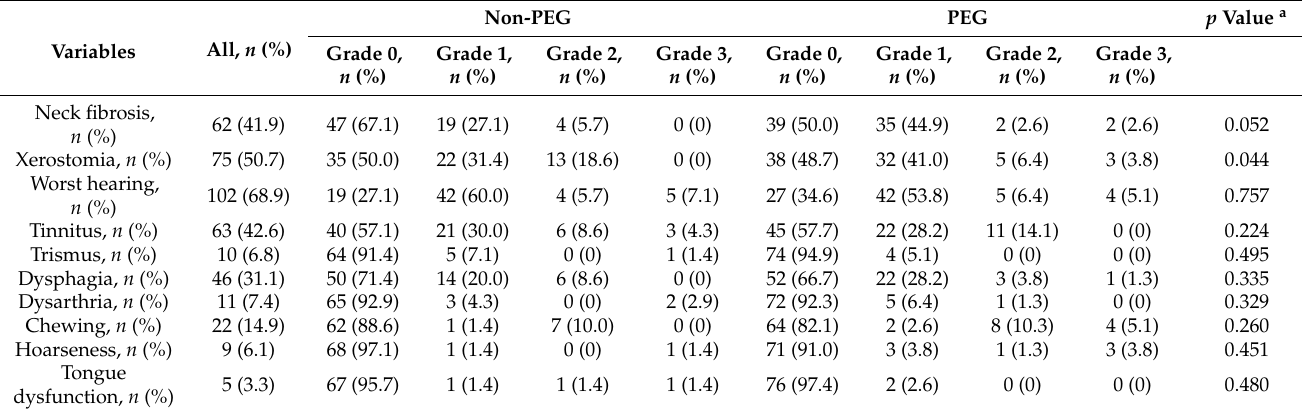
Table 2. Comparison of late toxicities between non-PEG and PEG groups.